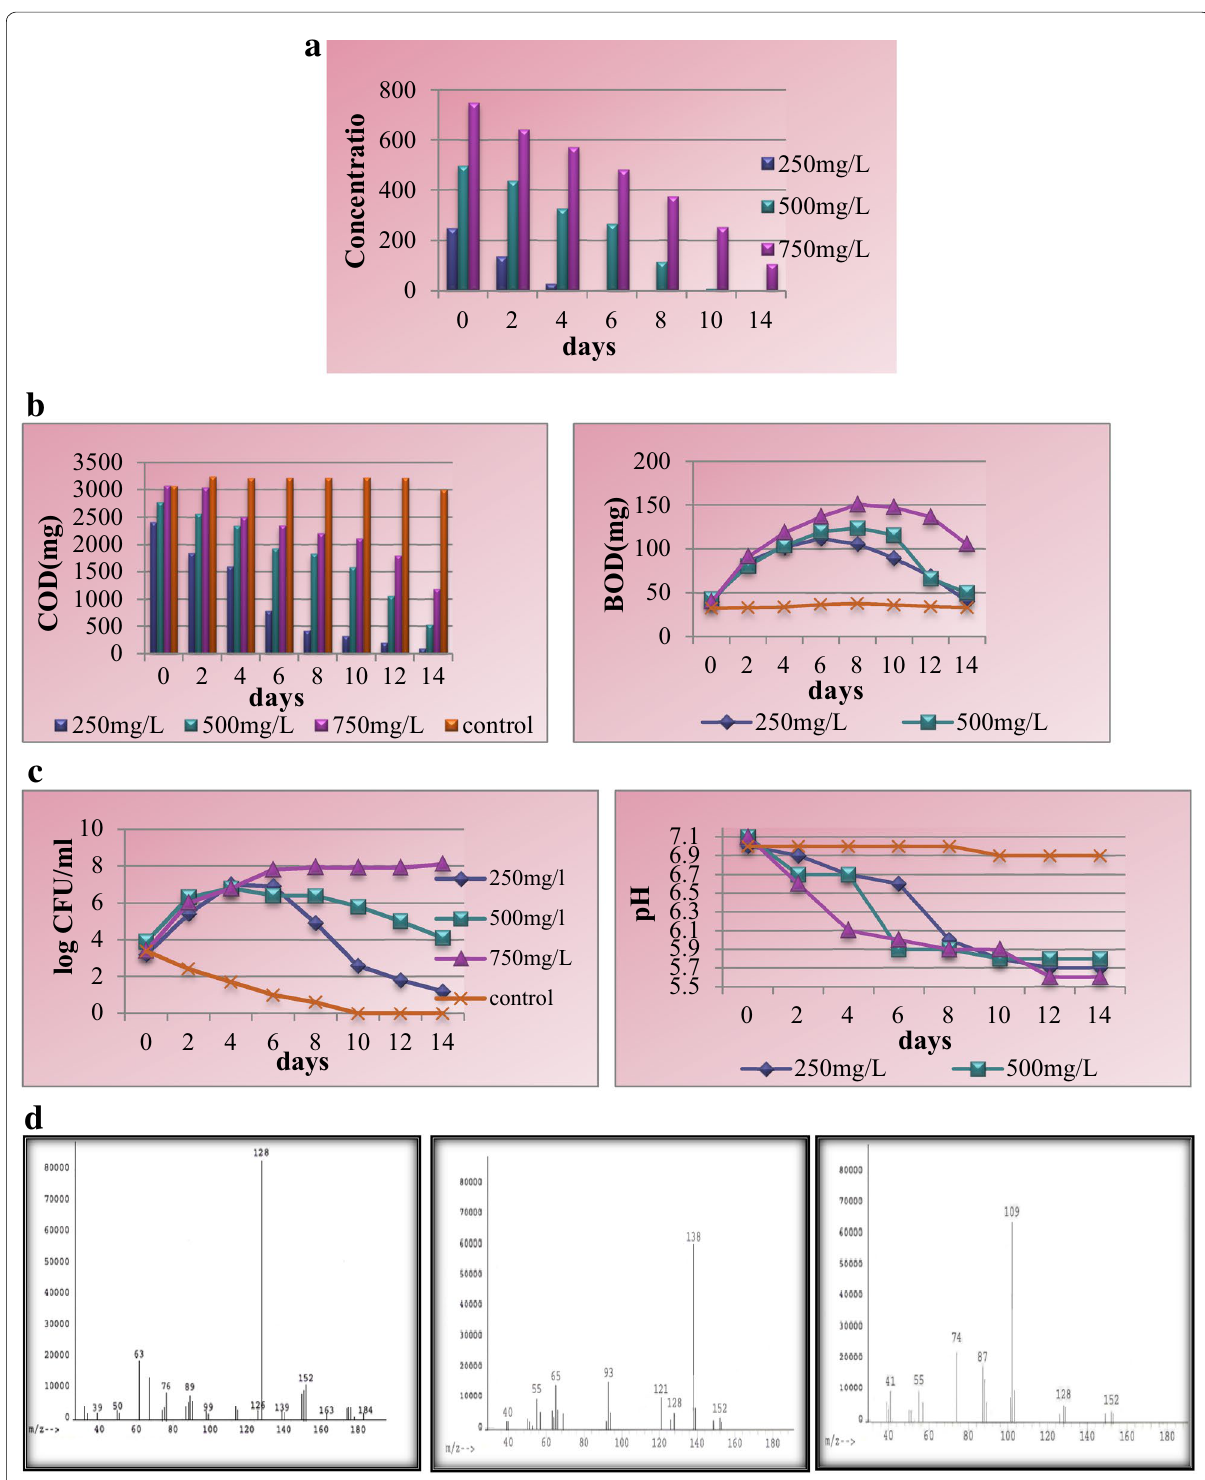
Fig. 1 a Degradation of naphthalene by microbial consortium in TMM. b Variations in COD and BOD during bioremediation of naphthalene by microbial consortium in TMM. c Variations in viable count and pH during bioremediation of naphthalene by microbial consortium in TMM. d Mass spectra of naphthalene ( m/z identification-128), salicylic acid ( m/z identification-138), and catechol ( m/z